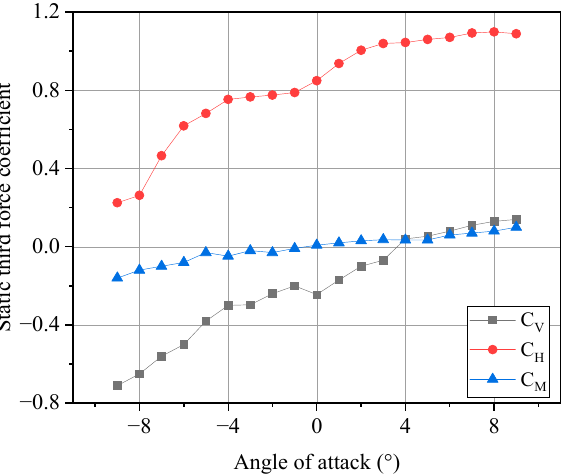
Figure 2. Aerodynamic force coefficient of the main girder of Xiangshan Harbor Bridge in body axis coordinate system. coordinate